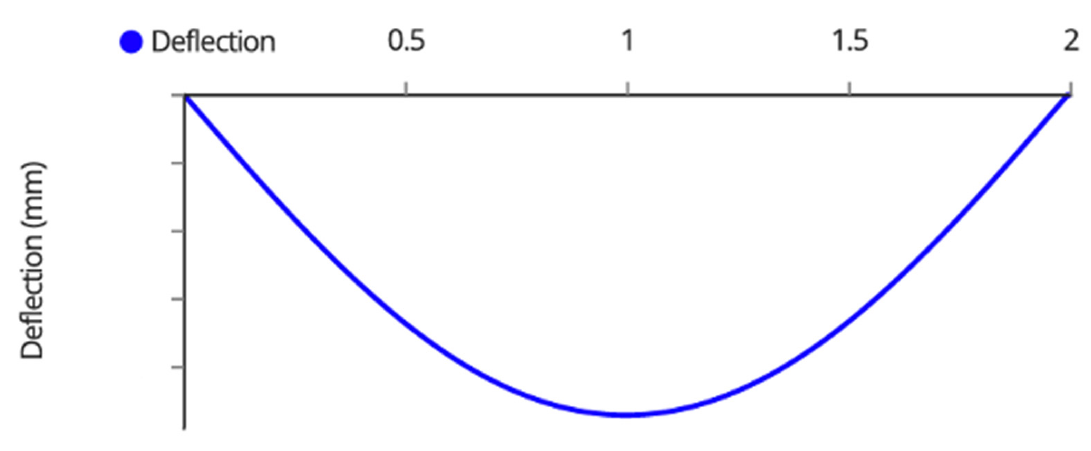
Figure A4. Joist Deflection Diagram.